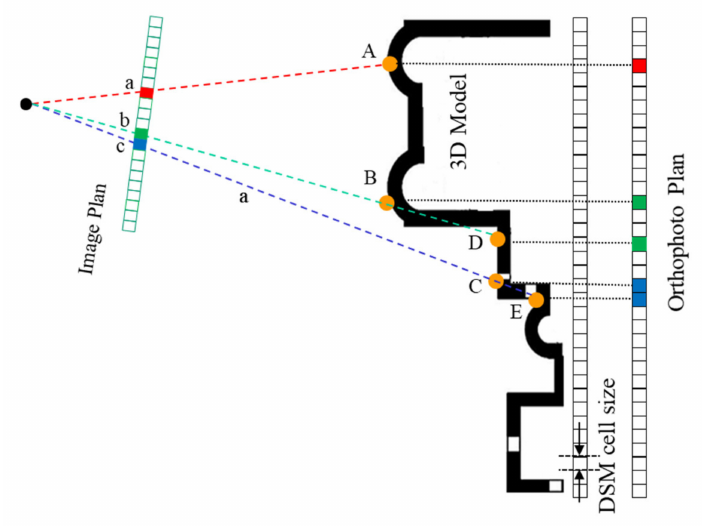
Figure 2. Di ff erential rectification method and double mapping e ff